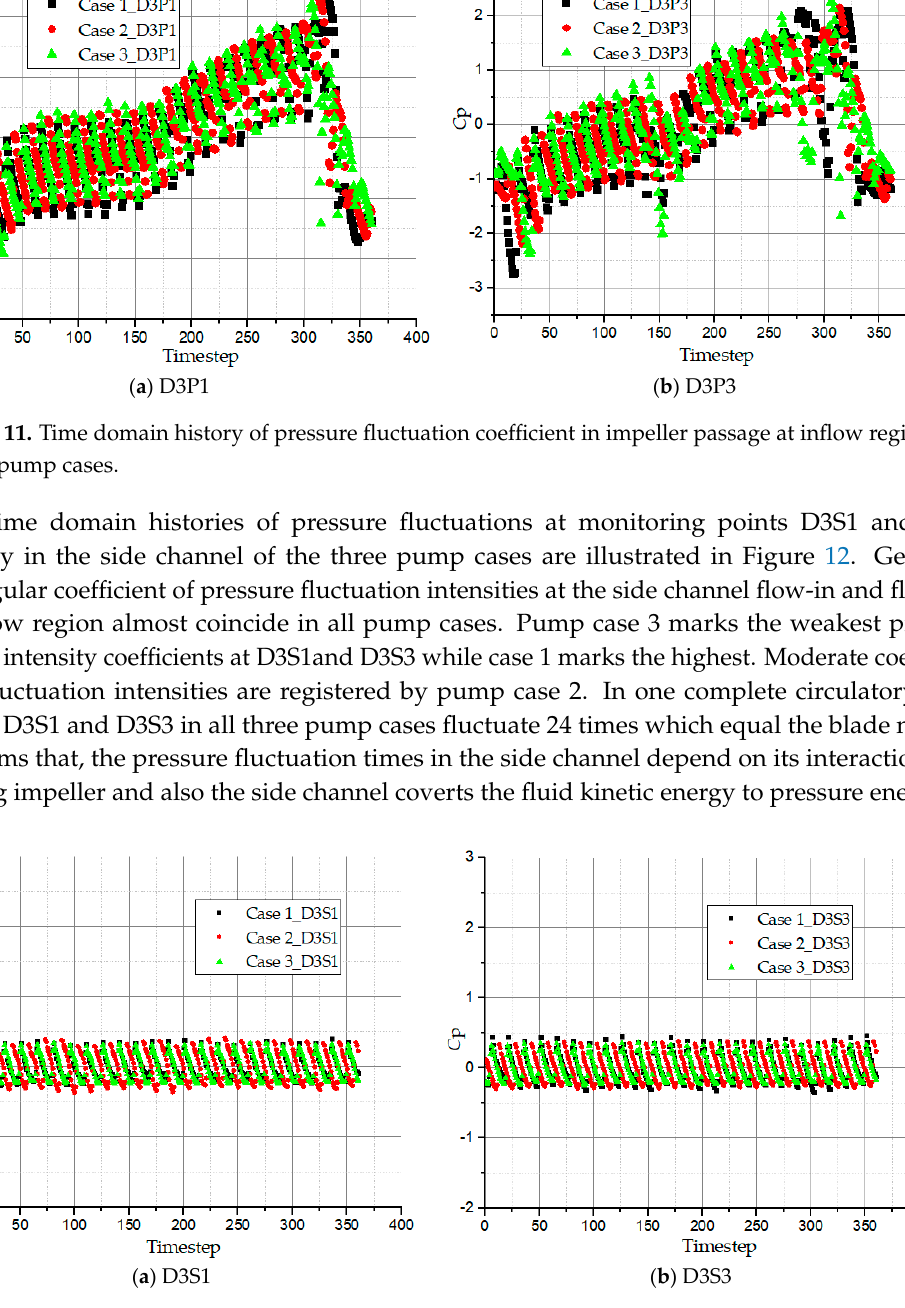
Figure 12. Time domain history of pressure fluctuation coefficient in side channel passage at inflow region for all pump cases.